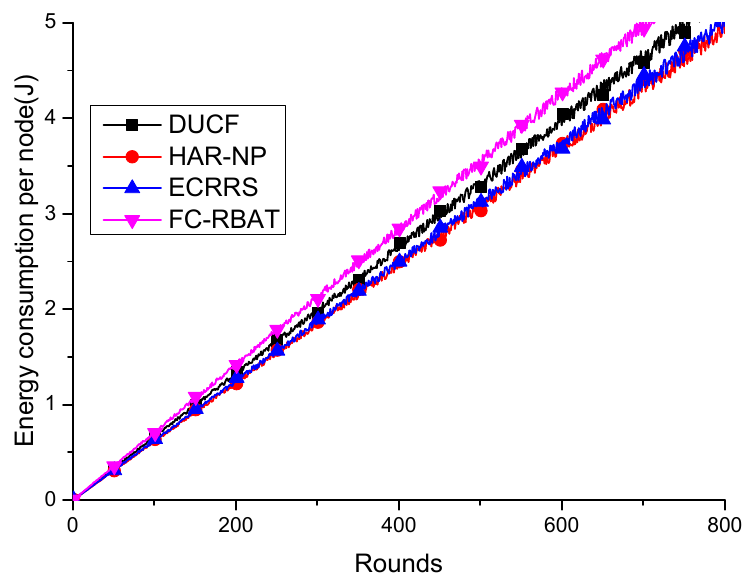
Figure 5. Average energy consumption of network nodes.